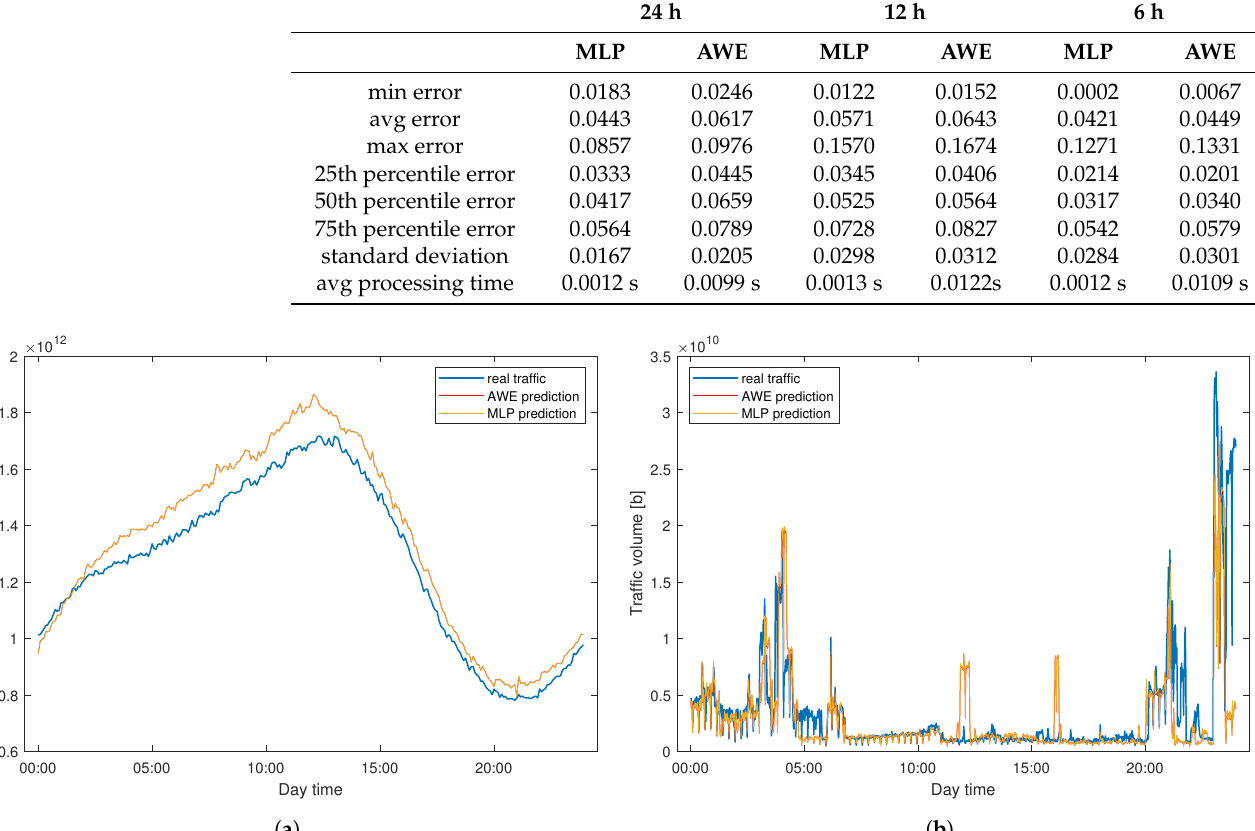
Table 6. Efficiency of machine learning-based traffic prediction for SIX dataset for different time windows.